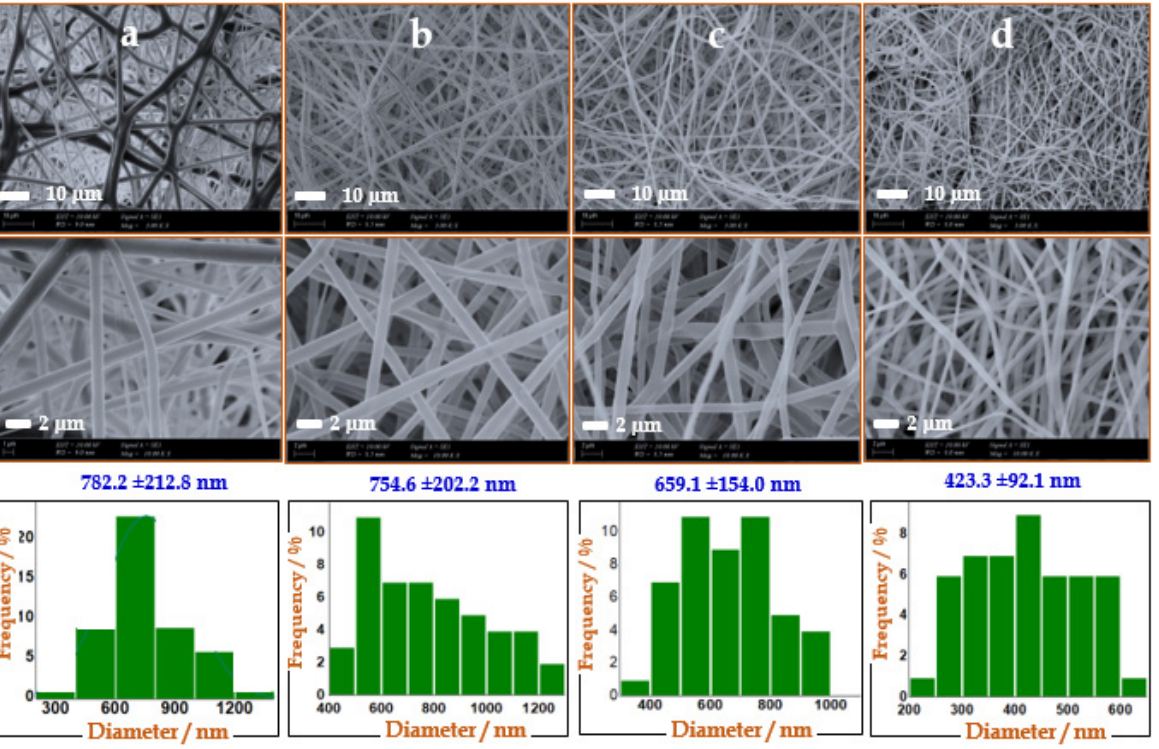
Figure 2. SEM images and diameters histograms of the electrospun nanofibrous trilayer membranes: ( a ) pure-F1, ( b ) nCeO 2 -F2, ( c ) nCeO 2 -F3 and ( d ) nCeO 2 -F4.